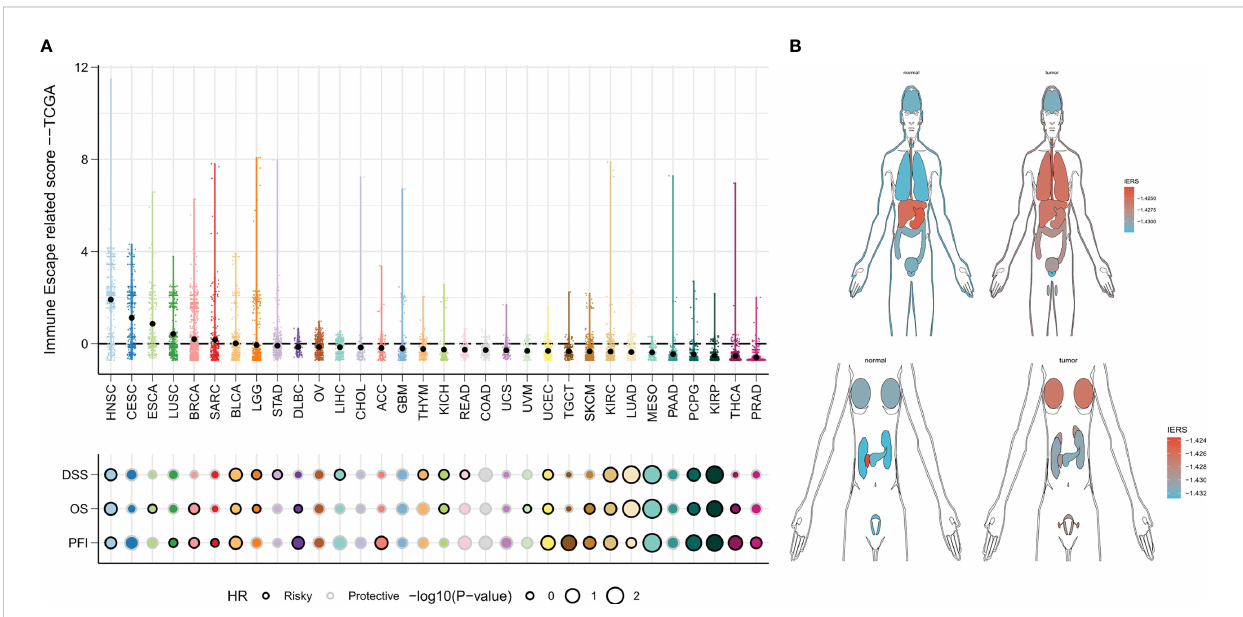
FIGURE 10 IERS in a Pan-Cancer Perspective (A) Distribution and univariate Cox regression analysis of IERS in different solid tumors. (B) Distribution of IERS in different organs and